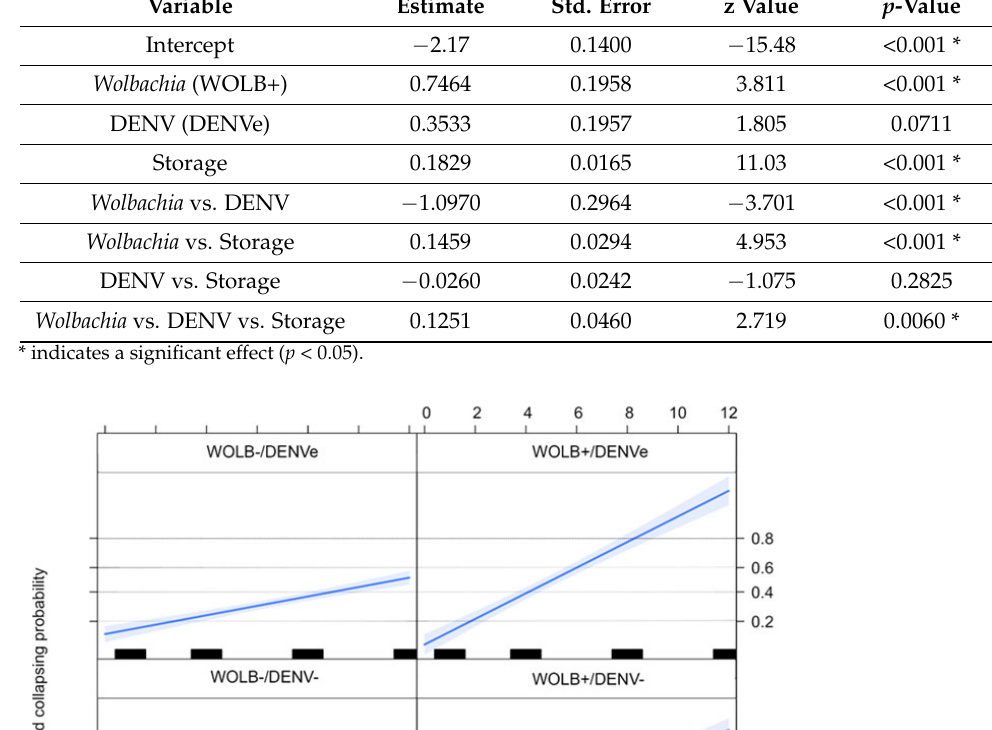
Table 3. Logistic regression for the e ff ect of Wolbachia presence, DENV exposure and storage time on egg collapsing.